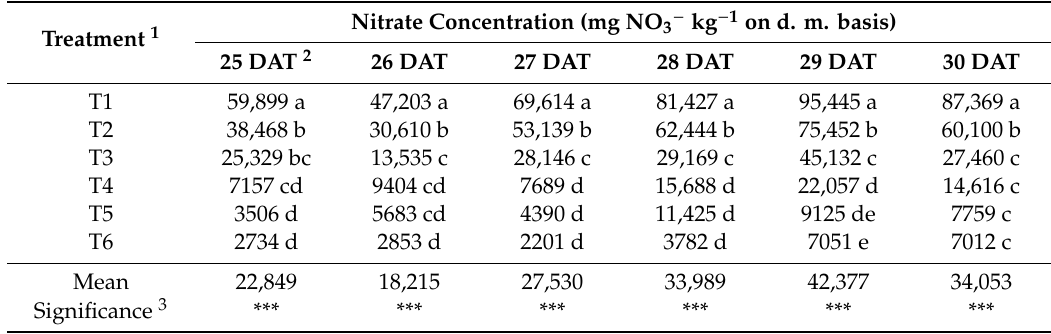
Table 11. Spring trial: nitrate concentration in lettuce on dry matter basis. Treatment